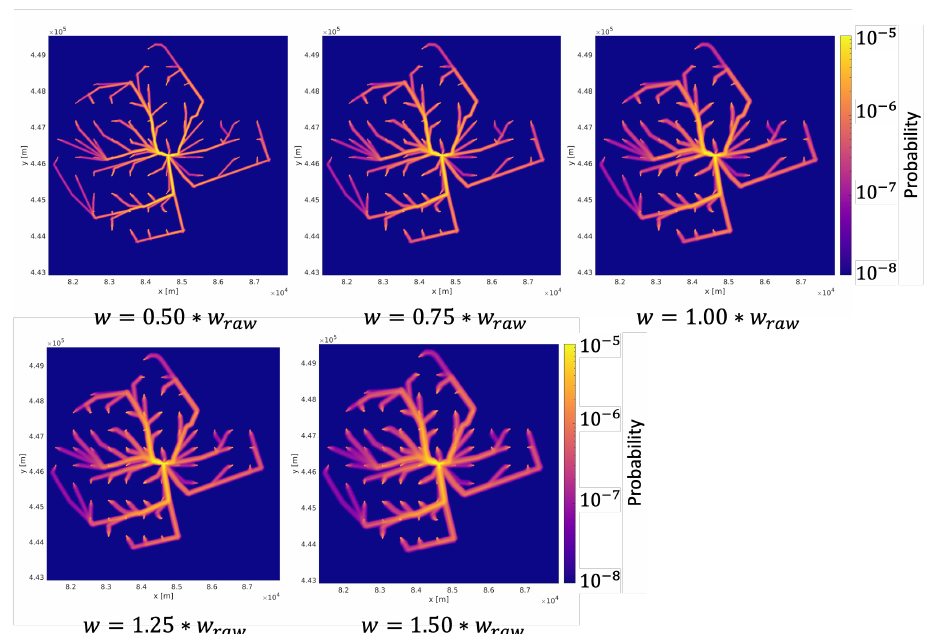
Figure A7. Annual IR with different wind speed w .